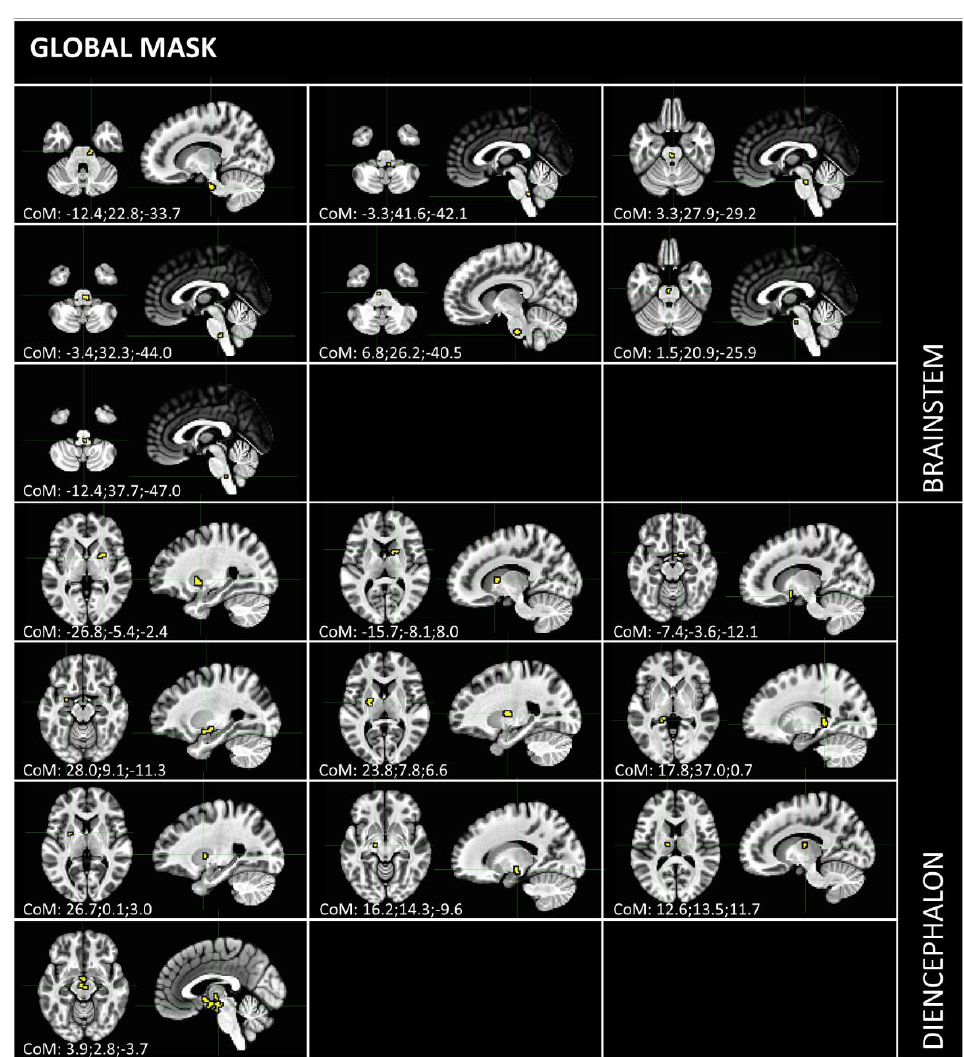
Figure 5. Clusters of supralinear activation for the 19 (0%) – 17 (3%) – 18 (7%) triplet extracted from